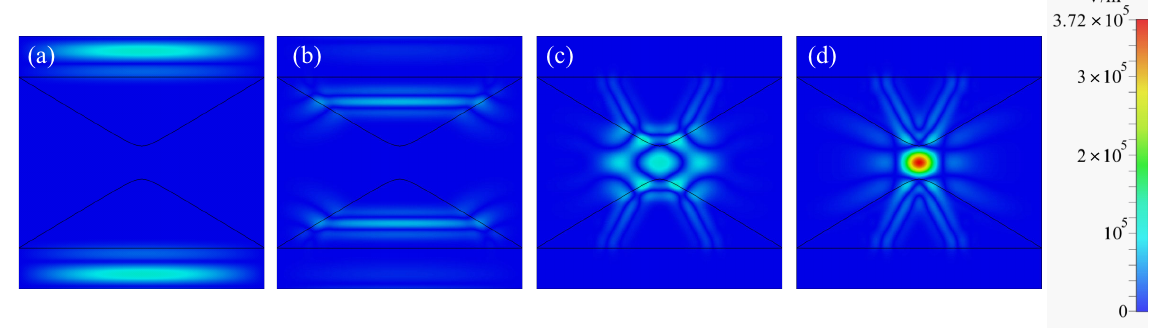
FIG. 4. E-field distributions at the quartz lens while focusing the short THz pulse. From the time when the THz pulse arrives at the lens, t ¼ 2 . 6 ps (a), focusing begins, t ¼ 5 . 6 ps (b), THz pulse is close to being focused, t ¼ 8 . 6 ps (c), and maximum of focusing, t ¼ 9 . 6 ps (d).